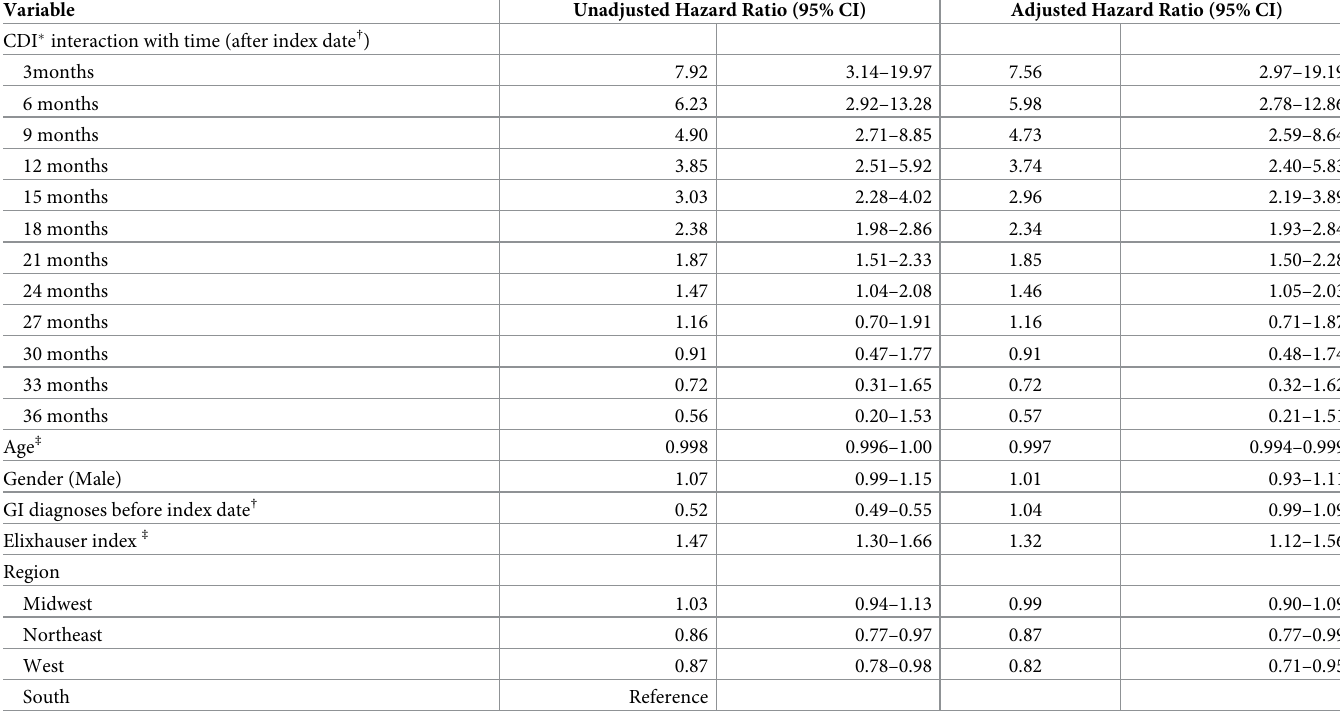
Table 2. Risk estimates of gastrointestinal (GI) diagnoses after an index case of Clostridium difficile .